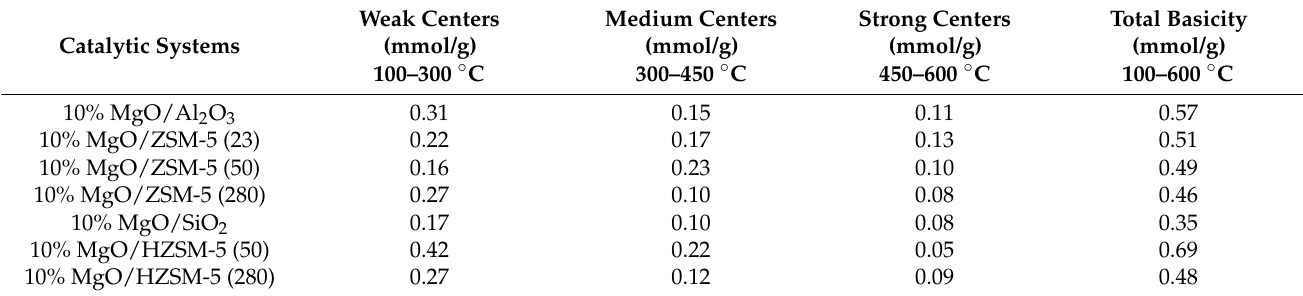
Table 5. The amount of CO 2 adsorbed on the support surface (calcined in an air atmosphere for 4 h at 500 ◦ C), magnesium oxides catalysts supported on ZSM-5 zeolite with a different silicon to aluminum ratio, calculated from the CO 2 -TPD profiles. The ratio of silicon to aluminum is given in